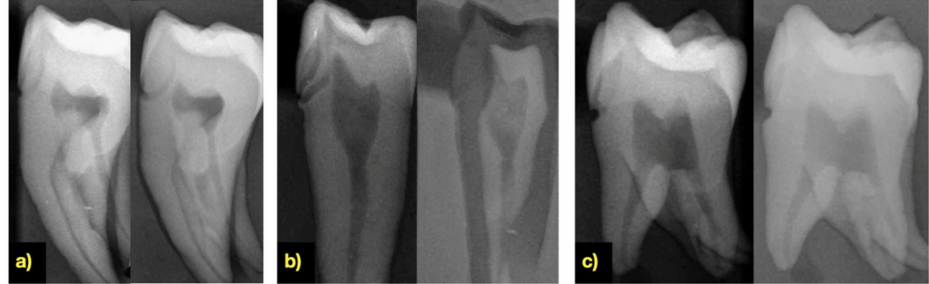
Figure 10. The radiologic aspect of the teeth before and after demineralization for 24 h with ( a ) hydrochloric acid gel; ( b ) orthophosphoric acid solution; ( c ) orthophosphoric